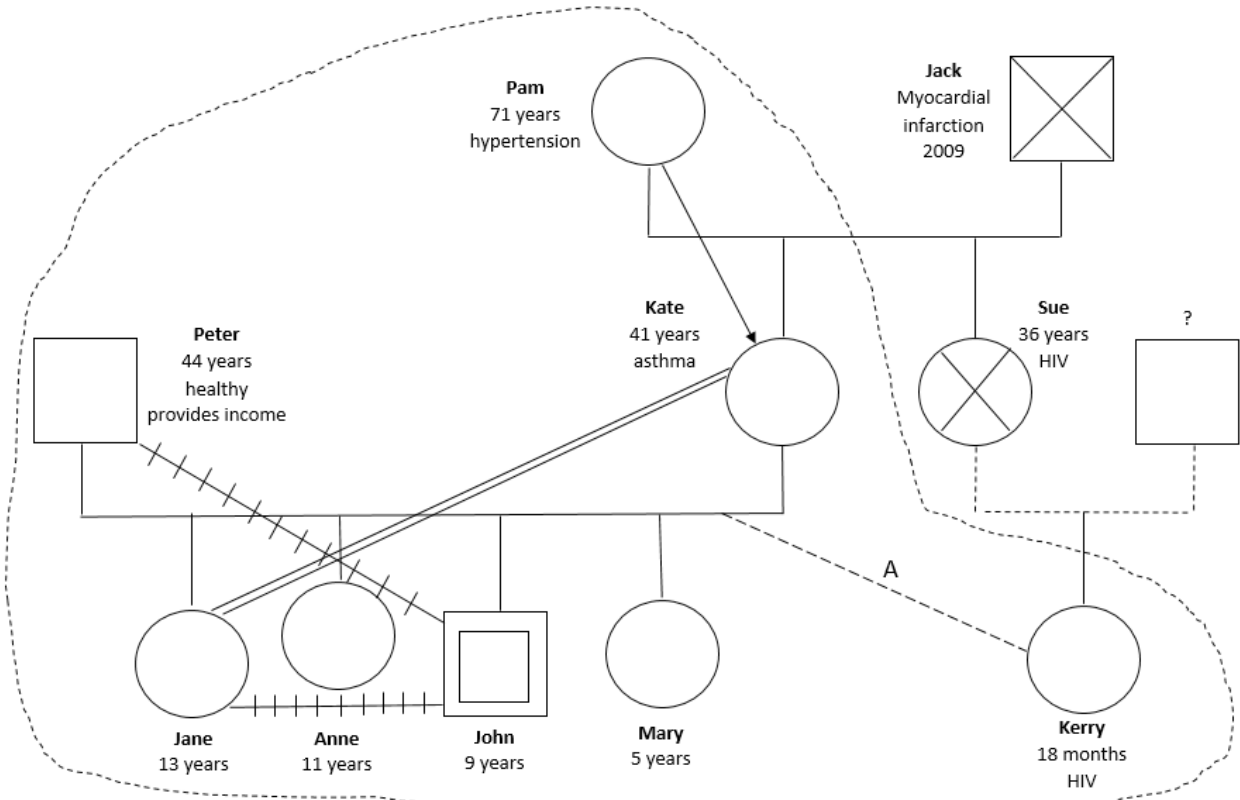
Figure 1: Genogram (Question